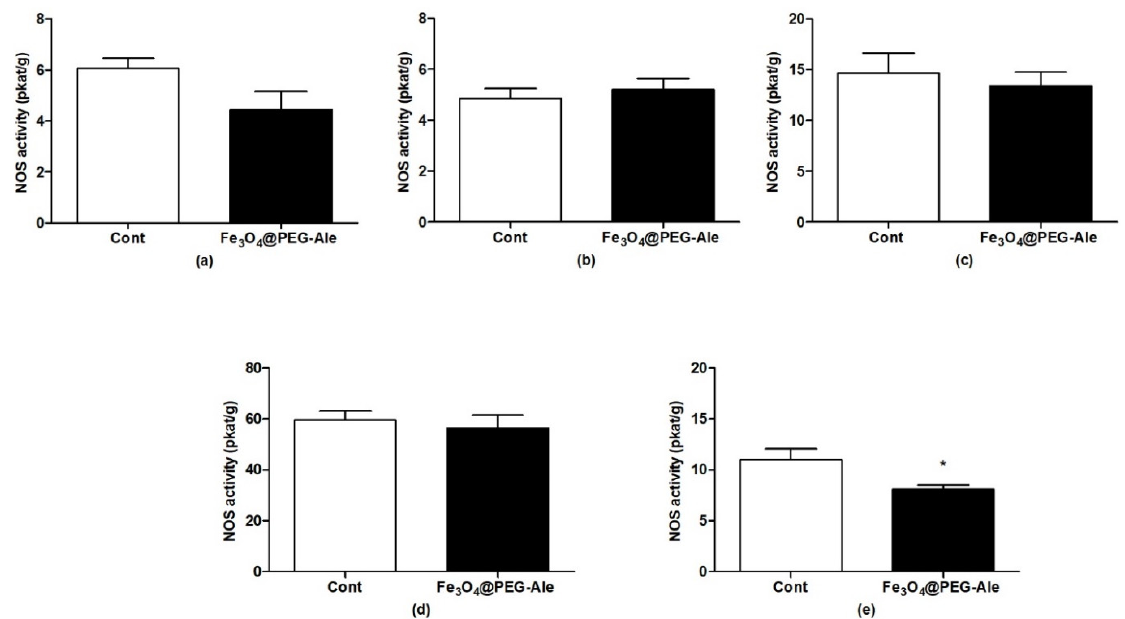
Figure 7. Nitric oxide synthase activities in ( a ) aorta, ( b ) left heart ventricle, ( c ) liver, ( d ) hypothalamus, and ( e ) kidney after IV administration of Fe 3 O 4 @PEG-Ale nanoparticles in rats. The values represent the mean ± SEM. * p < 0.05 vs. control group, n = 6–7 per group. Cont, control; NOS, nitric oxide synthase; Fe 3 O 4 @PEG-Ale, Fe 3 O 4 @PEG-alendronate nanoparticles.